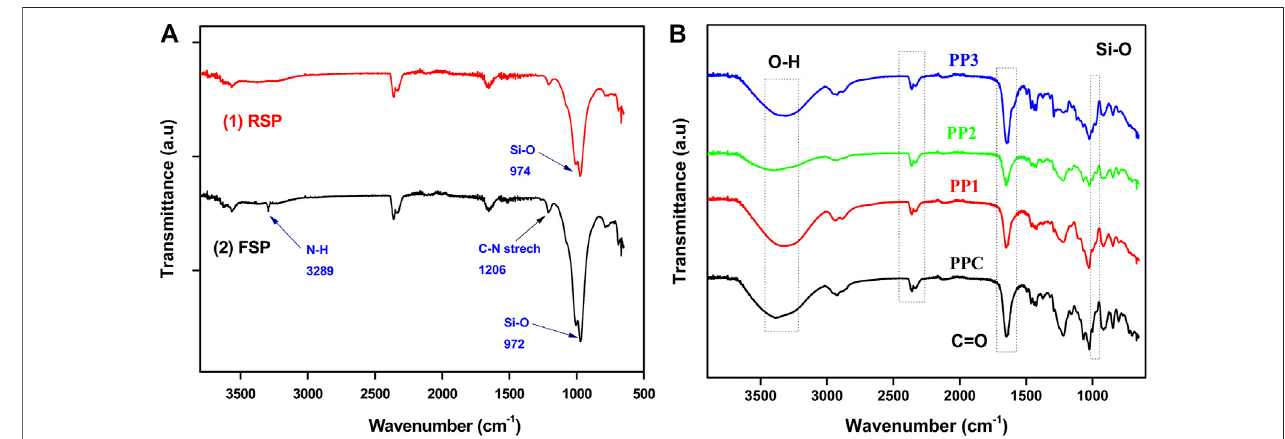
FIGURE 1 | (A) FTIR spectral analysis of modi fi cation of sepiolite clay with 3-APDEMS (B) FTIR spectral analysis of PPC, PP1, PP2, and PP3 semi-IPNs.